Question: From the figure, is the trend upward or downward?
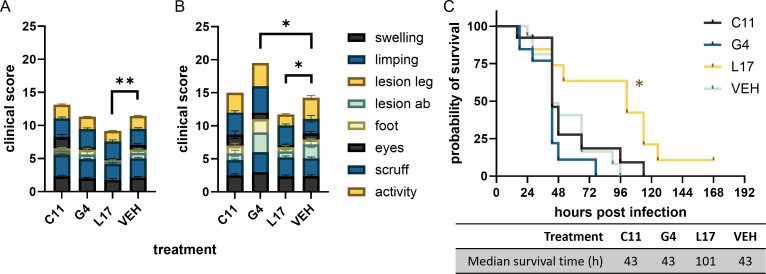
Answer: increasing